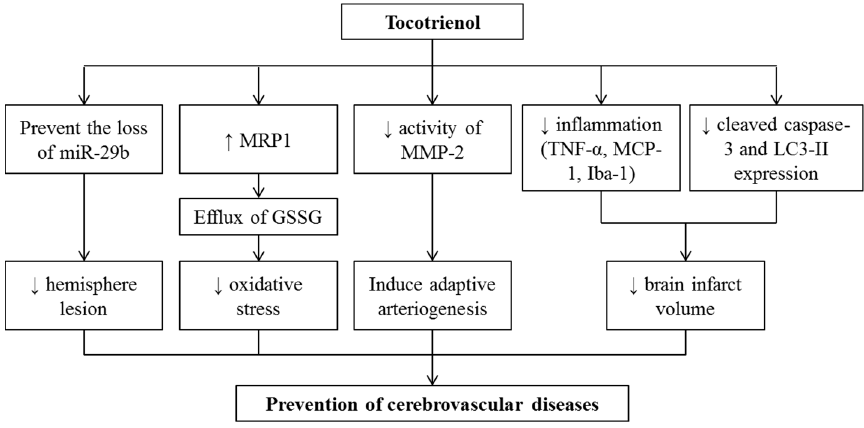
Figure 3. Effects of T3 on cerebrovascular diseases. Figure 3. E ff ects of T3 on cerebrovascular